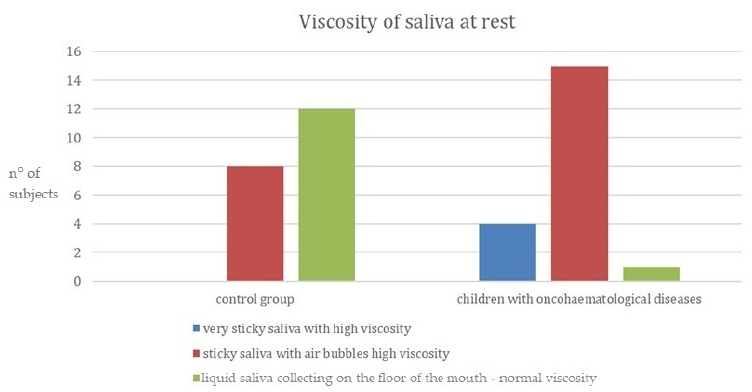
Figure 2. Viscosity of saliva at rest. ( y -axis: n ◦ of subjects = number of subjects for each category). It can be observed that in the control group, 60% of the patients have liquid saliva with a normal viscosity. By contrast, in the group of children with oncohematological diseases, 75% of the patients have sticky saliva with air bubbles corresponding to a high viscosity. In with high